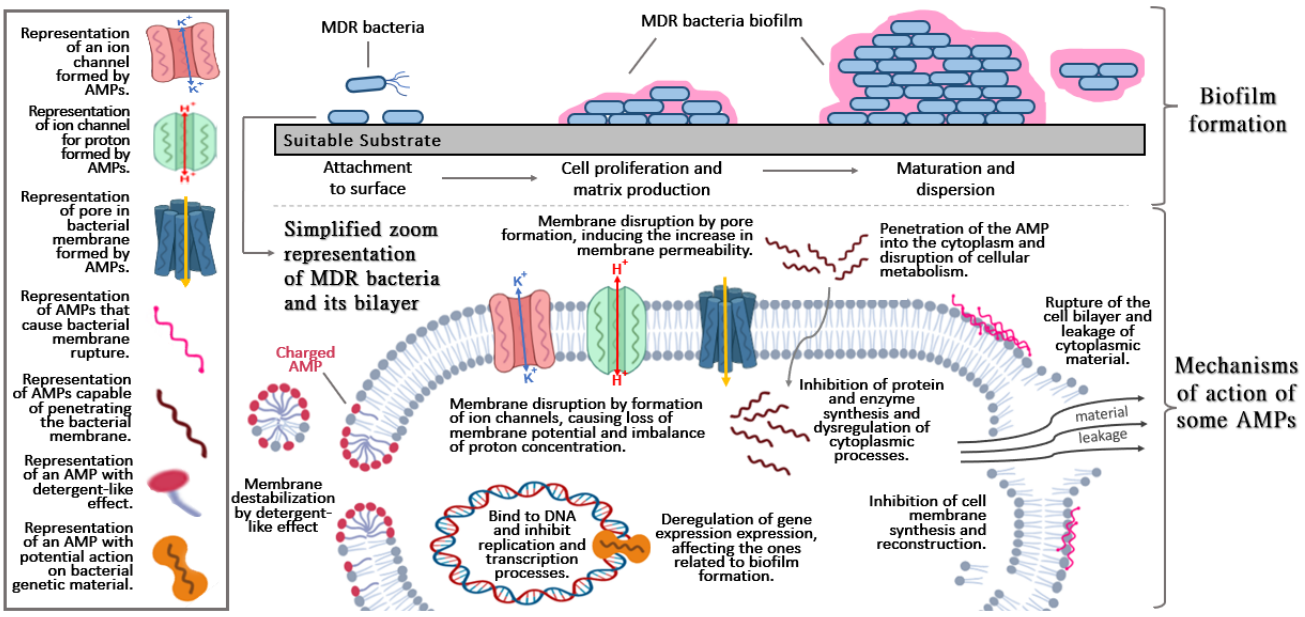
Figure 2. Basic and general aspects of biofilm formation ( upper section ) and brief description of the mechanisms action of antimicrobial peptides (AMPs) ( lower section ). mechanisms action of antimicrobial peptides (AMPs) ( lower section